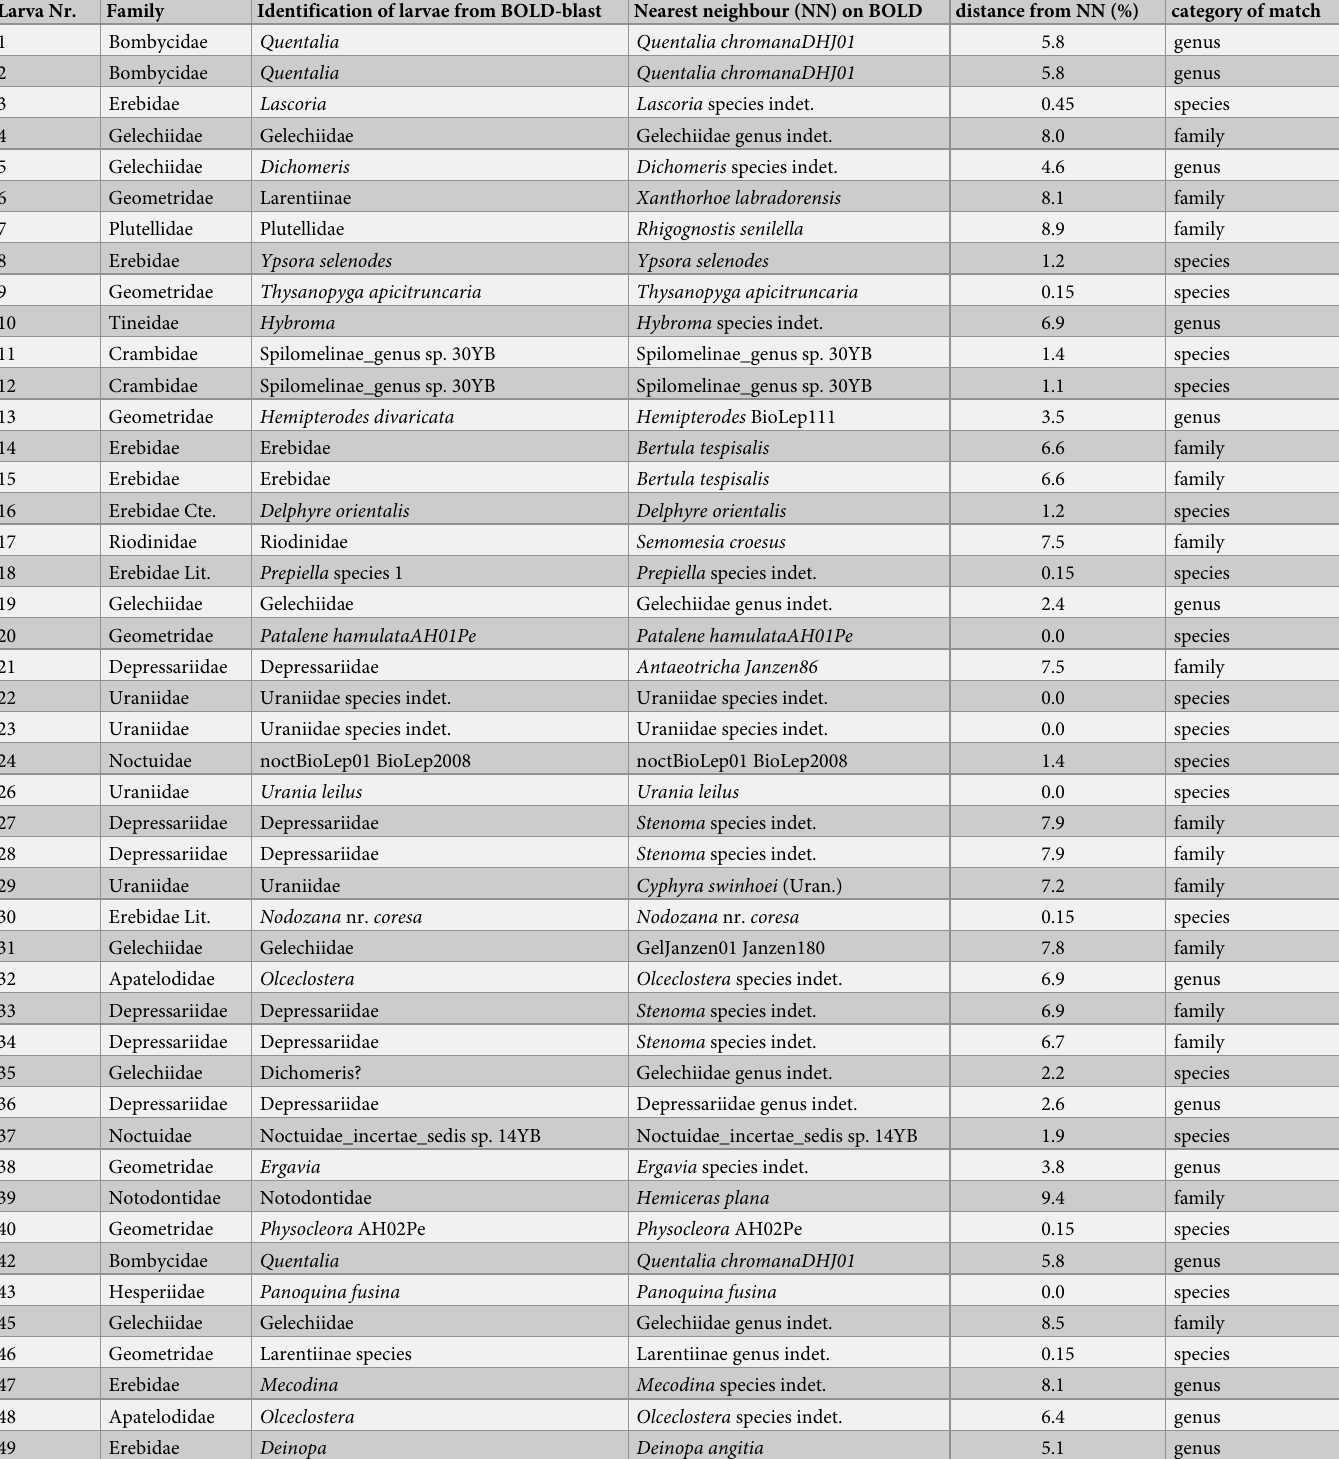
Table 2. Identification results from sequence blasting on BOLD for 119 successfully sequenced Lepidoptera larvae (see Table 1) and their distances from the nearest genetic neighbour. Larva